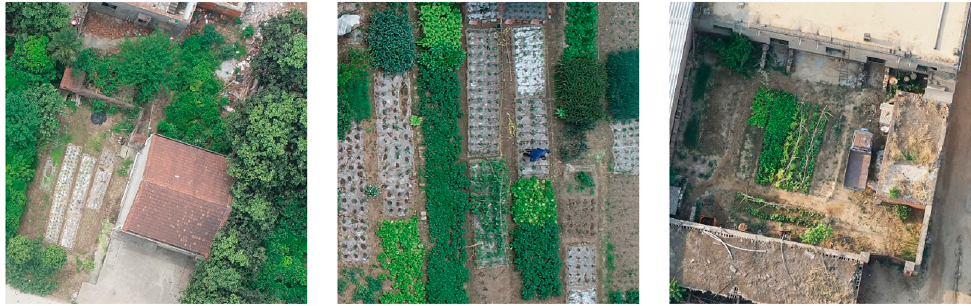
Figure 19. Complexity of the background in UAV images, including buildings, other crops, and shrubs.